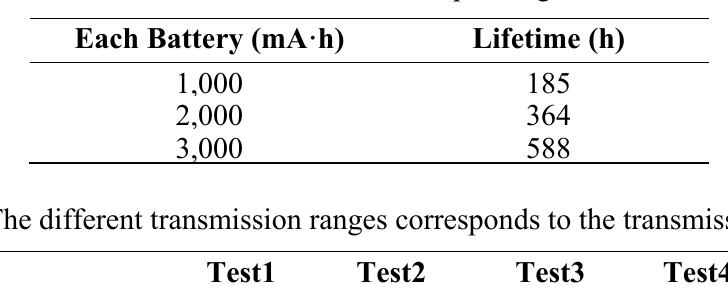
Table 2. Different lifetime to corresponding AA batteries.